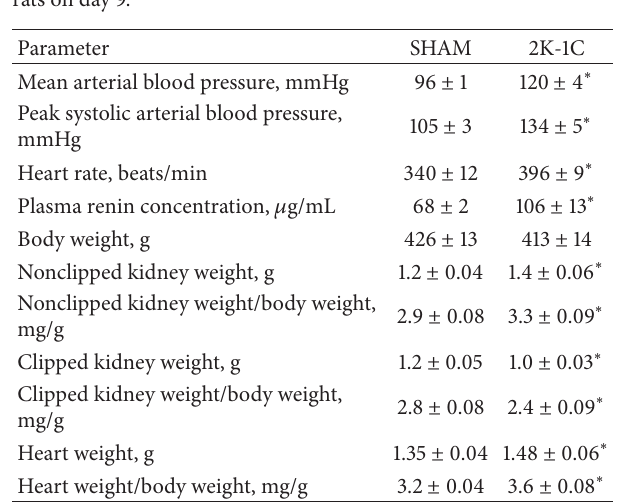
Table 1: Body and tissue weight parameters in SHAM and 2K-1C rats on day 9.